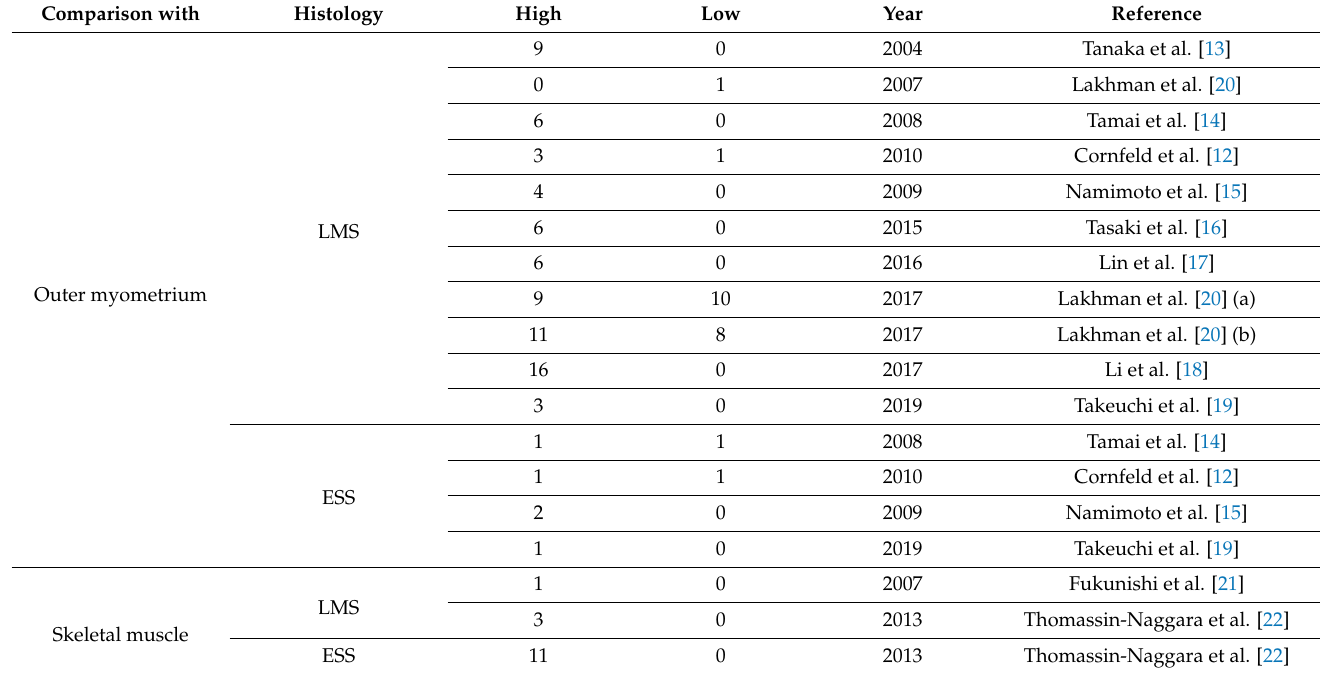
Table 2. The signal intensity of uterine sarcoma for T2WI.